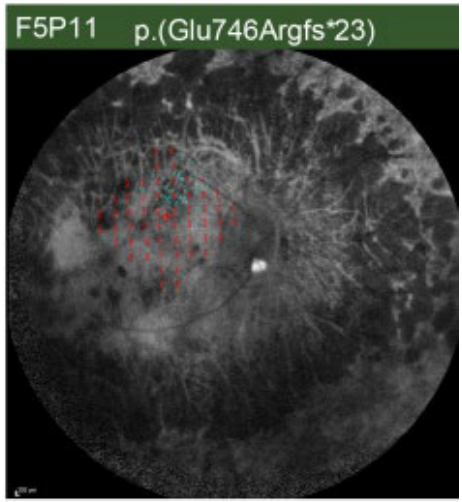
Figure 6. Microperimetry of the male RP patient F5P11 superimposed over corresponding 55° FAF images. Retinal sensitivity of 56 tested loci is represented by a color scale ranging from red (0 dB) to green (20 dB). Fixation points (represented by blue dots) determined a preferred retinal locus. The male patient had end-stage disease with complete loss of photoreceptors, therefore his fixation was not reliable.